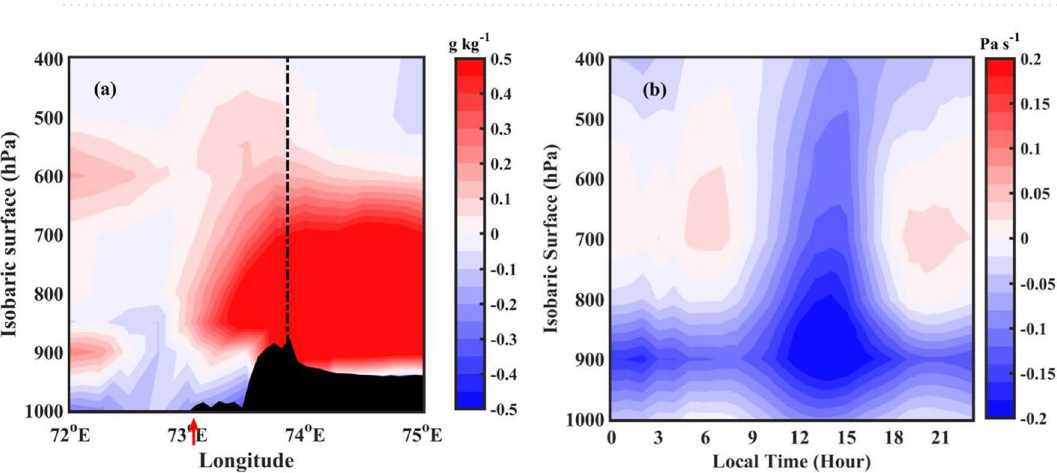
Figure 7. ( a ) Longitude-height (in pressure coordinates) cross-section of specific humidity difference between afternoon (1200–1500 LT), and nighttime (0000–0300 LT) over radar domain. ( b ) Time-height (in pressure coordinates) cross-section of omega (vertical velocity in pressure coordinates; Pa s −1